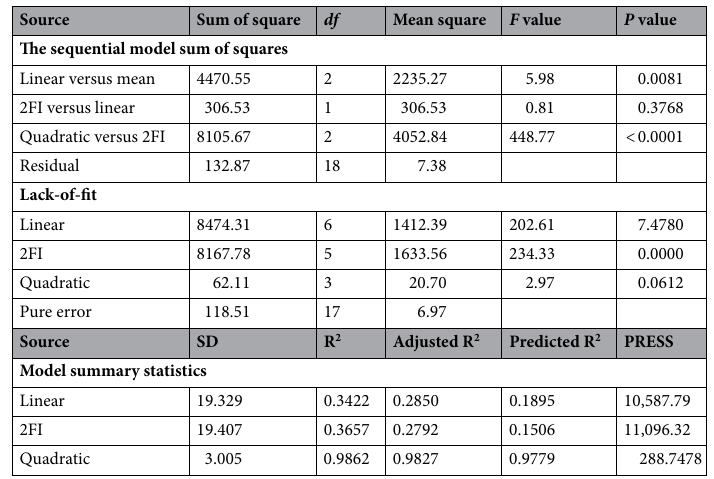
Table 4. Fitness and adequacy of the models based on the experimental data of the design matrix of the RCCD. df the degree of freedom, 2FI two factors interaction, SD standard deviation, R 2 determination coefficient, PRESS the sum of squares of prediction error.